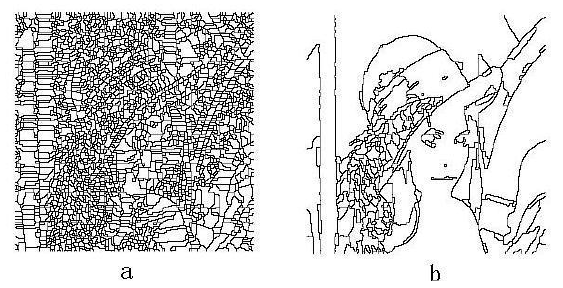
Fig 2. Image pixel neighborhood